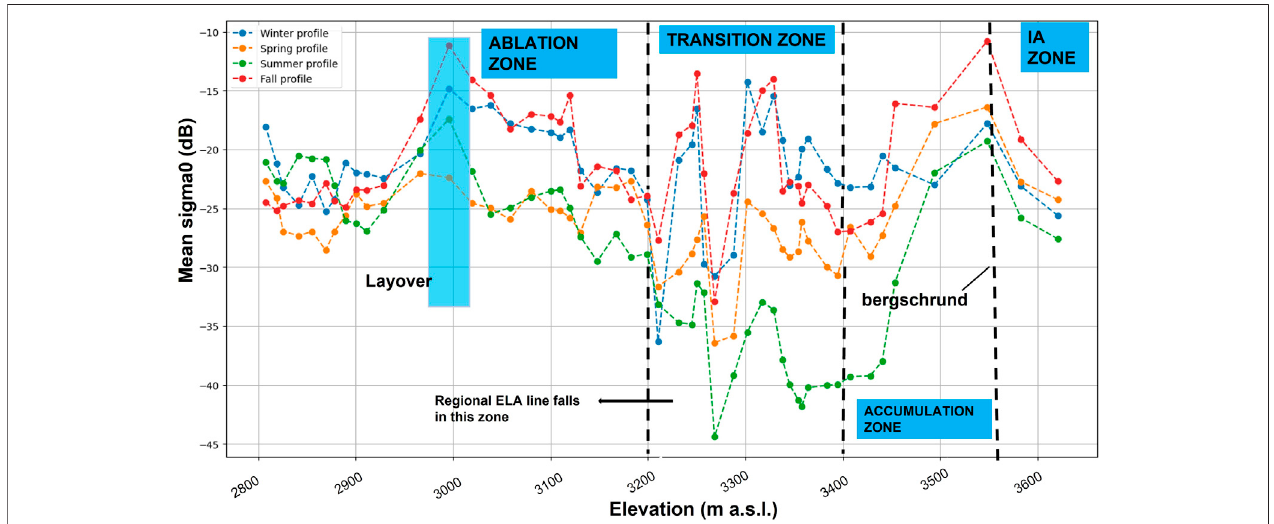
FIGURE 5 | Temporal pro fi le of backscattering signals on PAZ images in 2020 along the Brenva glacier.